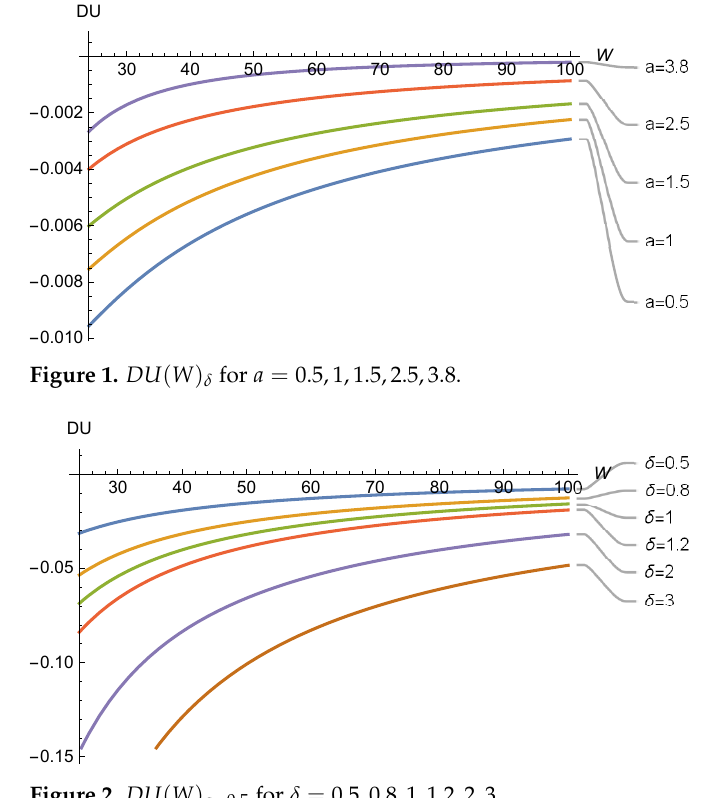
Figure 2. DU ( W ) a = 0.5 for δ = 0.5,0.8,1,1.2,2,3.